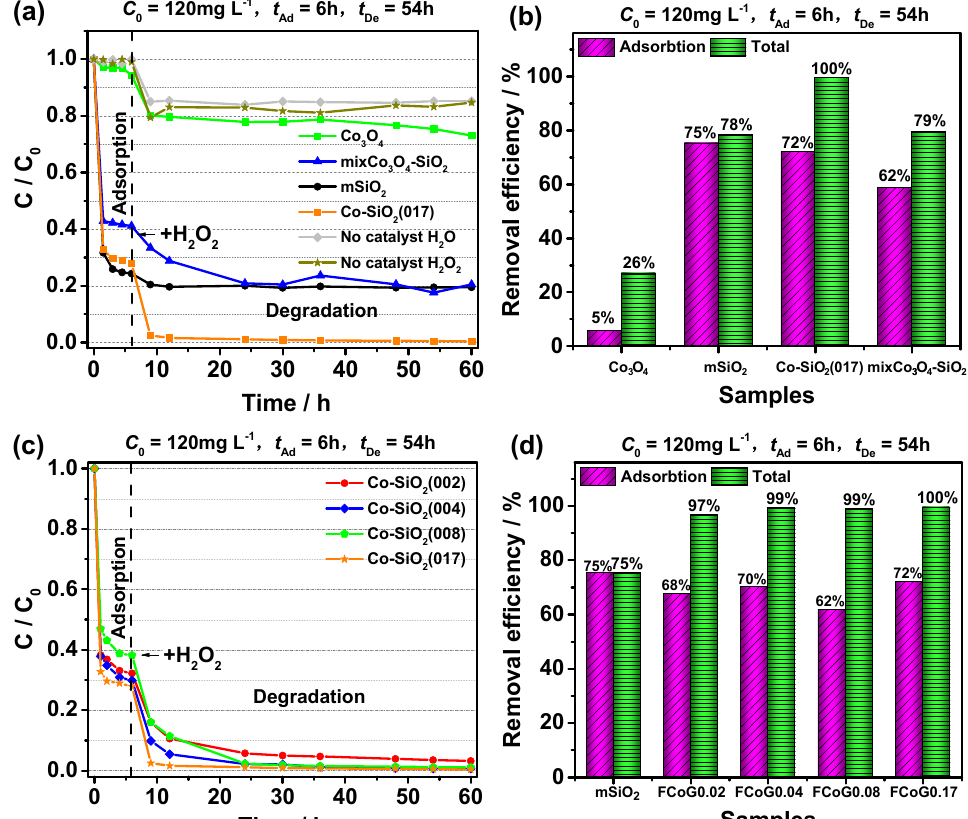
Figure 7. Adsorption and catalytic degradation ( a ) and the removal efficiency ( b ) of methylene blue (MB) by different catalysts. Adsorption and catalytic degradation ( c ) and the removal efficiency of MB ( d ) by the Co ‐ SiO 2 ( x ) catalysts with different Co content.